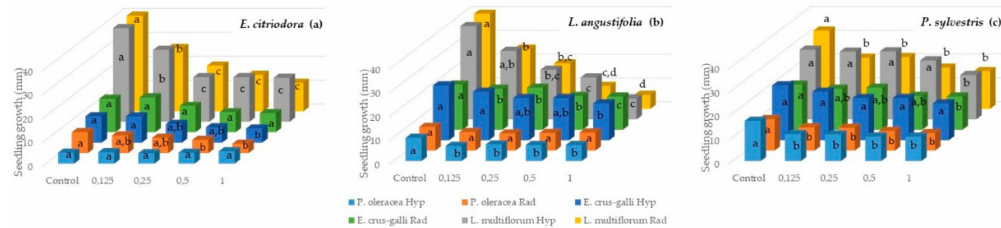
Figure 1. Phytotoxic e ff ect of E. citriodora ( a ), L. angustifolia ( b ), and P. sylvestris ( c ) essential oils on the seedling growth (hypocotyl and radicle) of P. oleracea , L. multiflorum , and E. crus-galli . Values are mean percentages of five replications, after 14 days of incubation. Doses 0.125–1 µ L / mL. Di ff erent letters indicate significant di ff erence at p < 0.05, according to T3 Dunnett and Tukey